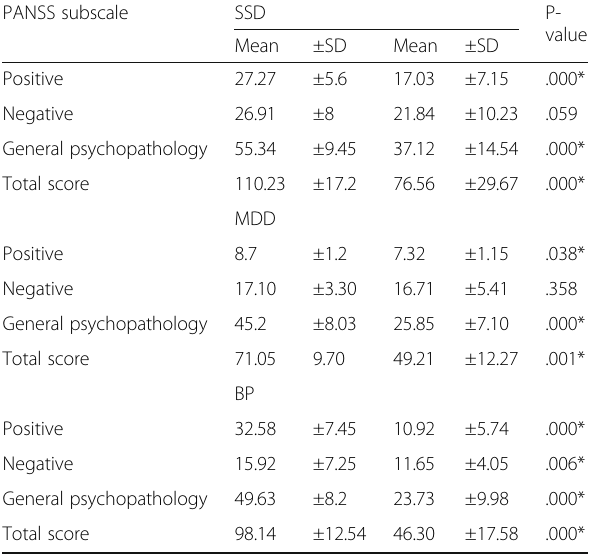
Table 5 Comparison of PANSS mean scores at first presentation and after 1 year follow-up PANSS